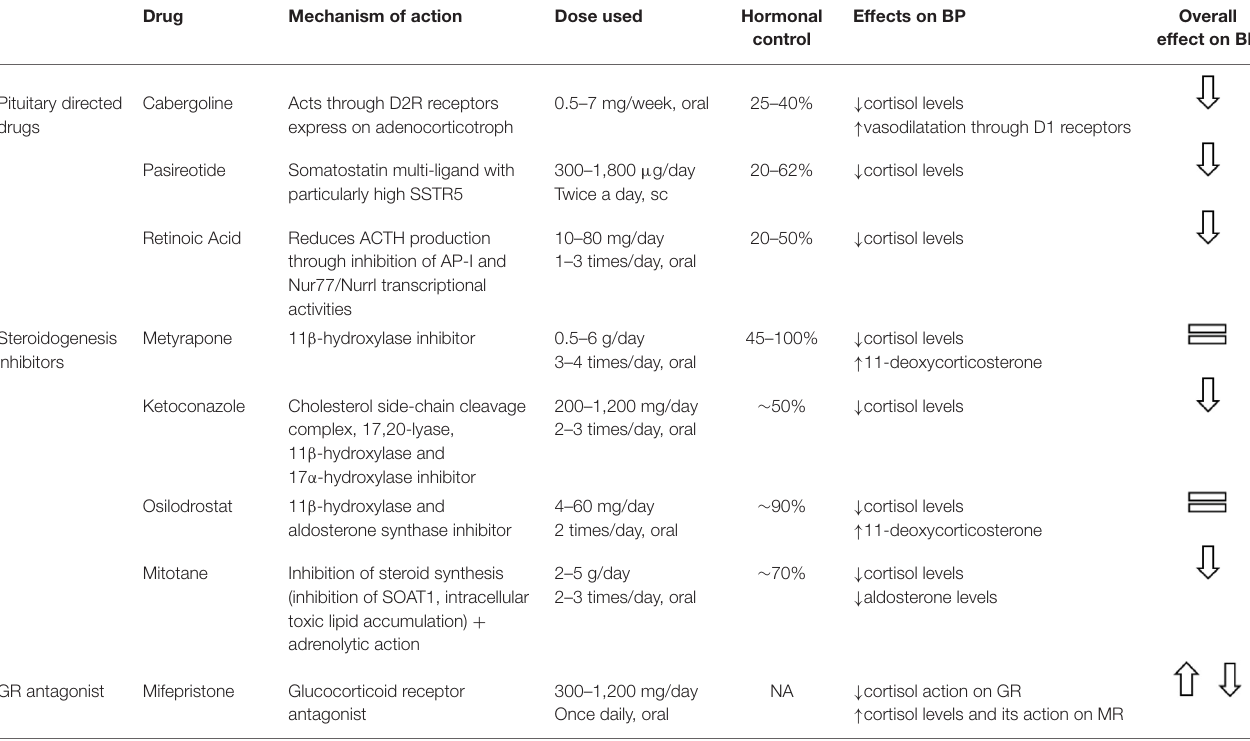
TABLE 1 | Cortisol lowering medications, their effectiveness and effects on hypertension in CS